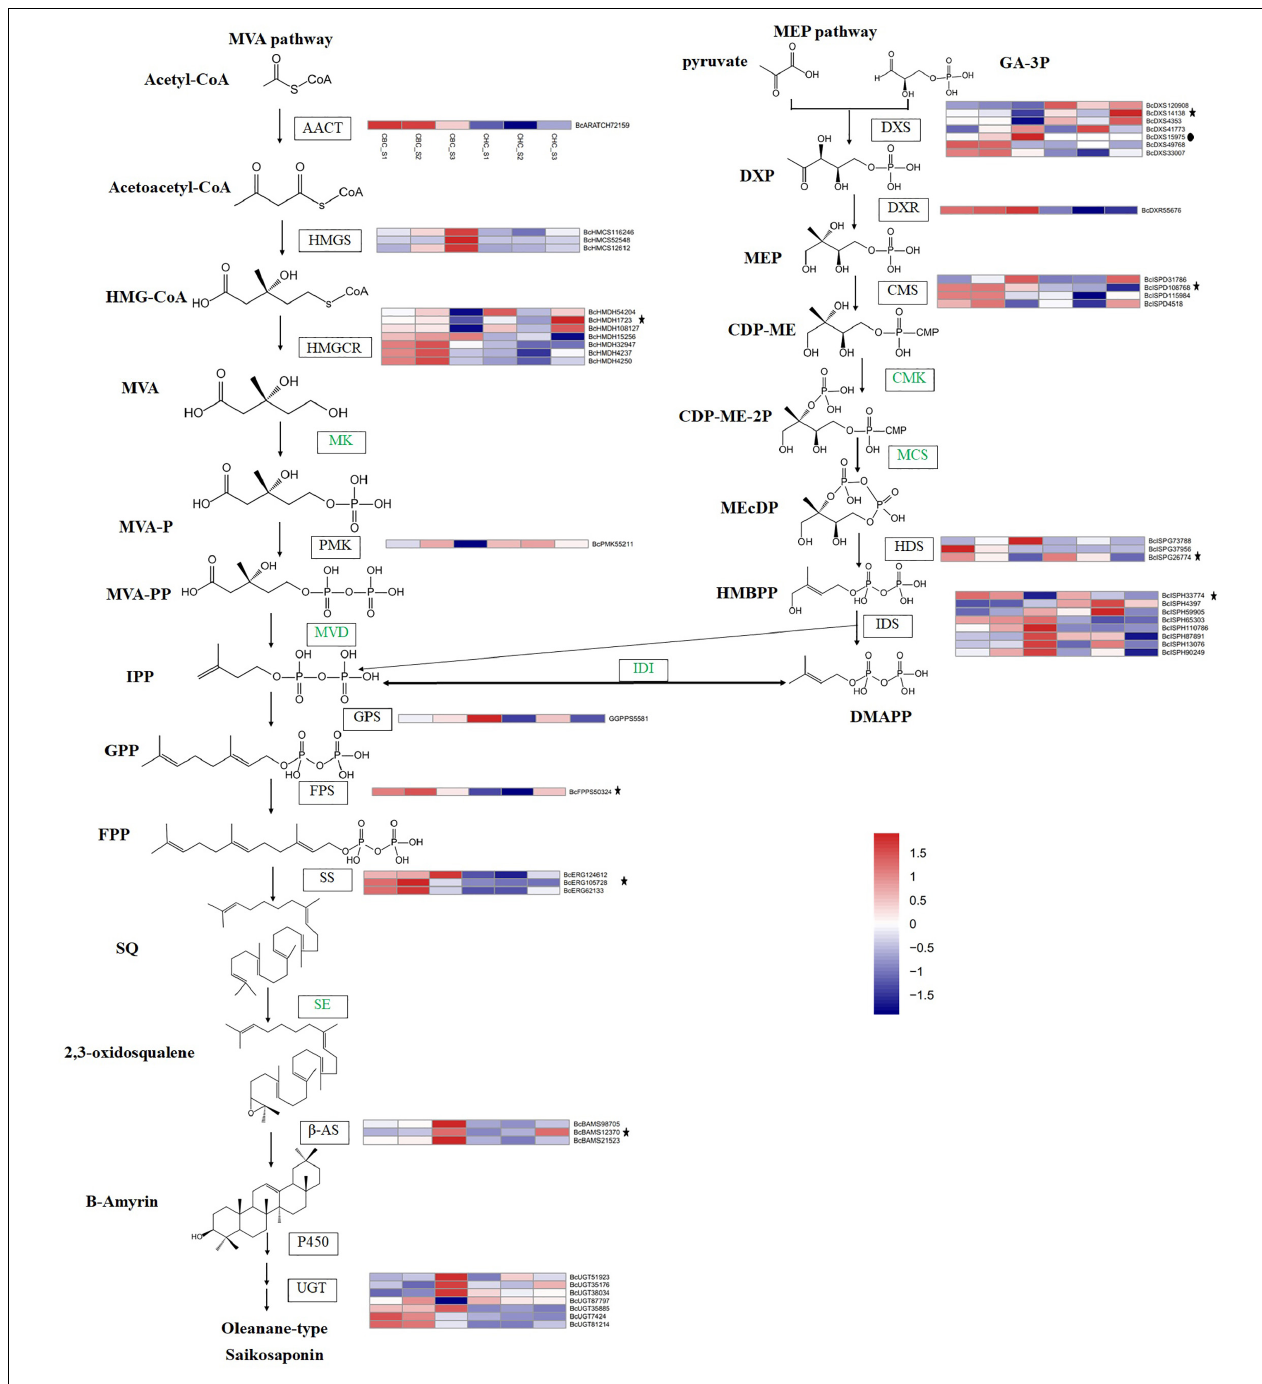
FIGURE 1 | Putative triterpenoid backbone biosynthesis pathway (MVA and MEP) in Bupleurum chinense DC. and Bupleurum scorzonerifolium Willd. and gene expression profiles of the key enzymes. All genes outside of these pathways showed significantly differential expression in S3 of B. chinense . The genes with asterisks also showed significantly differential expression in S3 of B. scorzonerifolium . The genes with solid dots indicate those detected only in B. chinense DC. The samples include S1 (F), S2 (T), and S3 (M) in B. chinense (CBC) and B. scorzonerifolium (CHC).